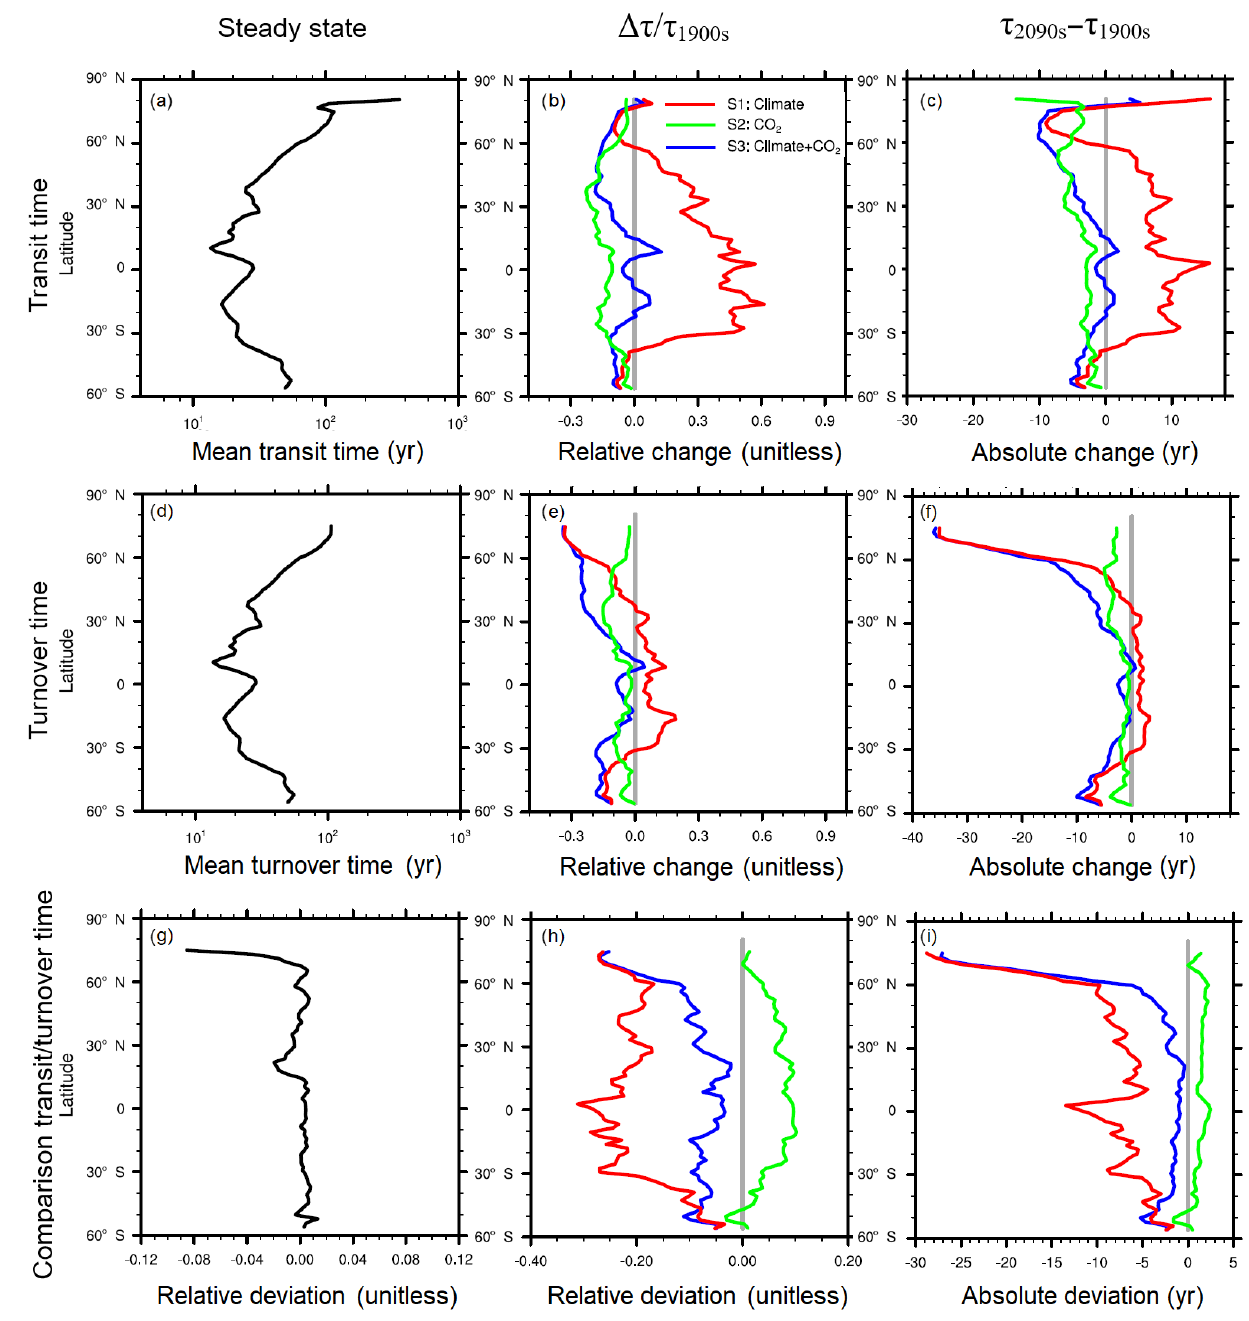
Figure 6. (a) Latitudinal variation in C transit time ( τ transit ) at steady state and (b, c) its change are compared to (d–f) C turnover time ( τ to ). The changes between the 2090s and 1900s are estimated by (c, f) absolute value: (cid:49)τ = (τ 2090s − τ 1900s ) and by (b, e) relative value: (cid:49)τ r = (cid:49)τ . (g) The deviation of C turnover time relative to C transit time is estimated by (τ to − τ ts )/τ ts at steady state. Relative to C transit τ 1900s time, the deviation of the change in C turnover time is estimated by (h) absolute deviation ( | (cid:49)τ to | − | (cid:49)τ ts | ) and (i) relative deviation in ( | (cid:49)τ to | − | (cid:49)τ ts | ) | (cid:49)τ ts | . All variables are compared in S1: only climate warming scenario (red line), S2: rising atmospheric [CO 2 ] scenario (green line), and S3: combined climate warming and rising atmospheric [CO 2 ] scenario (blue line). Grey lines in (b) , (c) , (e) , and (f) represent the reference lines of no change and those in (h) and (i) represent the reference line of no